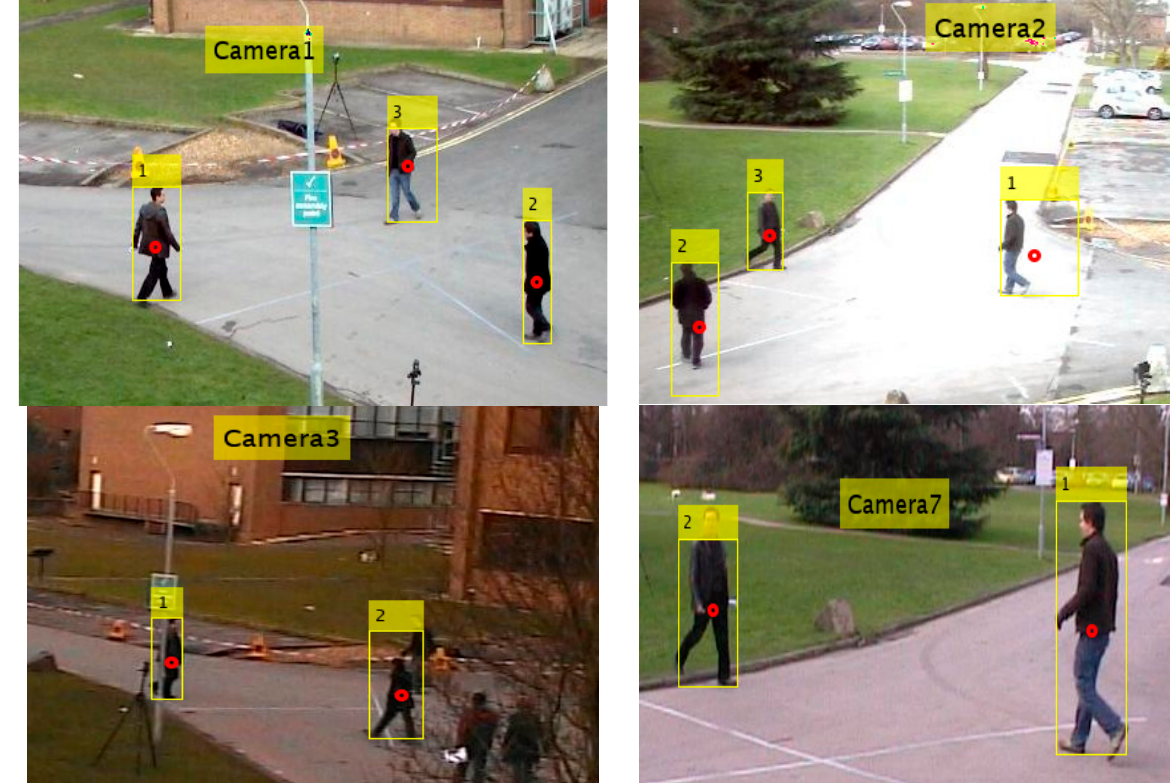
Figure 1. Targets detected within the FoVs of Cameras 1, 2, 3, and 7 and the assigned corresponding assigned identification numbers [27]. Red dots indicate centroids of each target.